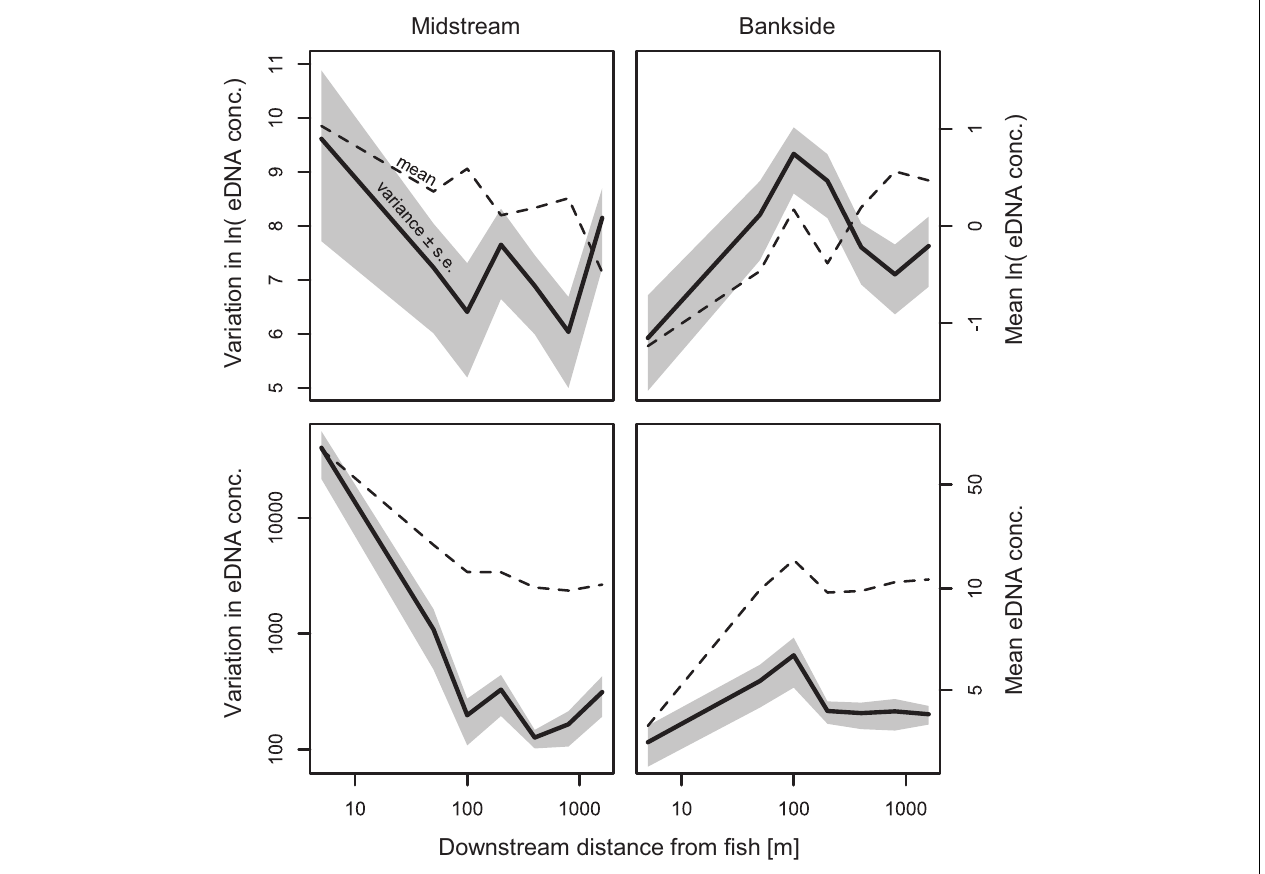
FIGURE 5 | Variation and mean eDNA abundance. Distance-specific variances for midstream and banks samples shown, pooled across all streams, dates, and fish abundances for each distance. Distances > 1,600 m, which were not sampled for all streams, were excluded from this figure. The variance of ln-transformed data reduces the potential effect of variance scaling with the mean [i.e., ln( µε ) becomes ln( µ ) + ln( ε )] and is less sensitive to